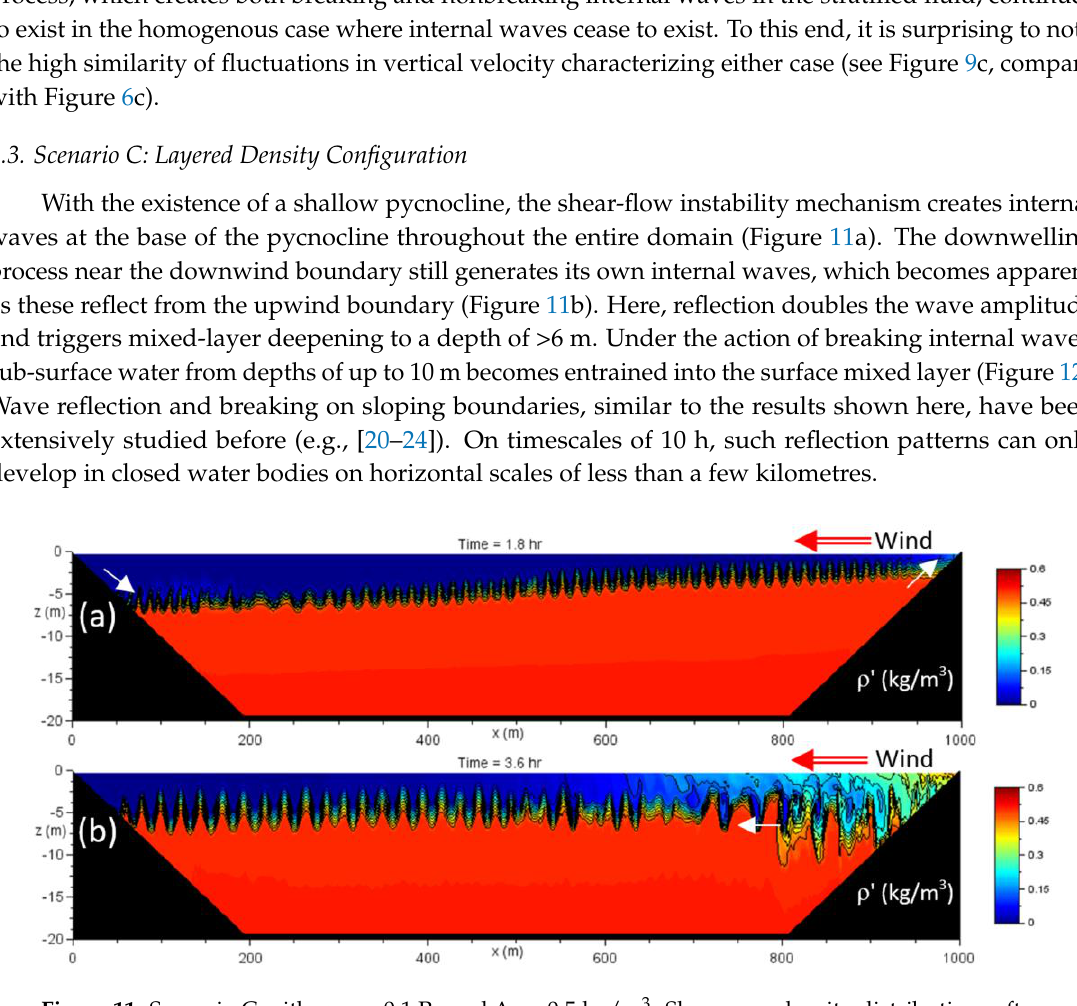
Figure 11. Scenario C with τ x = −0.1 Pa and Δ ρ = 0.5 kg/m 3 . Shown are density distributions after ( a ) 1.8 h and ( b ) 3.6 h of simulation. The small arrow in panel ( b ) indicates the propagation direction of internal waves after reflection. See GIF Animation S3 for a simulation of this experiment.